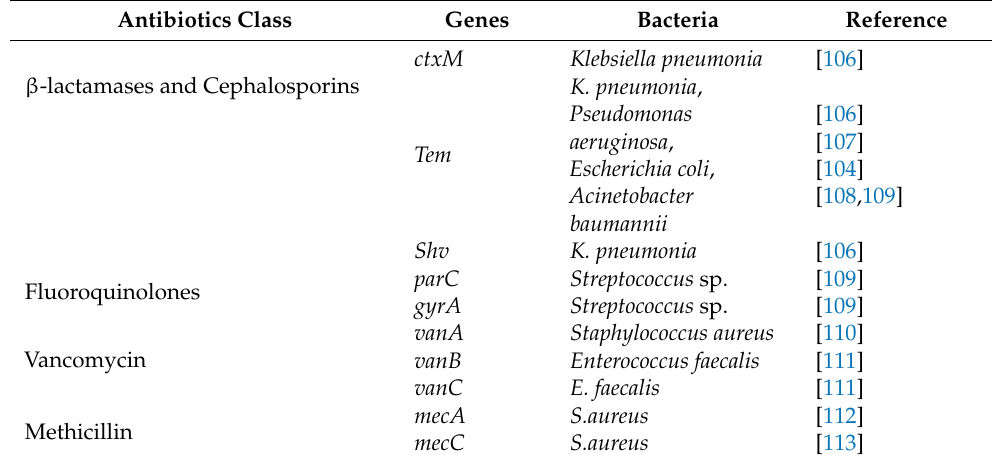
Figure 3. Molecular antimicrobial detecting testing assays. The ideas presented here are relevant to novel antimicrobial testing methods based on nucleic acid amplification. Arrows follow the direction from a clinical specimen to a diagnostic result. A process for the molecular test (right-sided) has been demonstrated, which includes quick sample preparation, amplification and amplicon characterization. Table 2. List of antibiotics classes, resistance marker genes and bacteria used in real-time